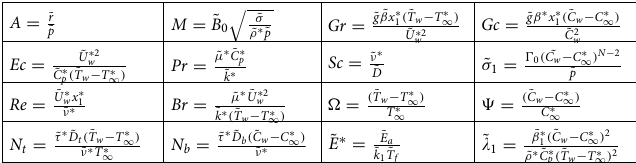
Table 1. Non-dimensional parameter used in